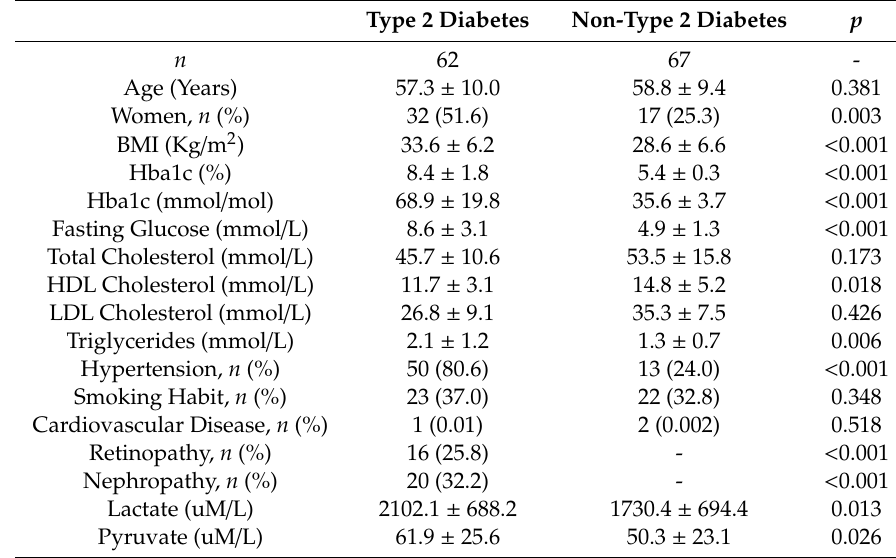
Table 1. Clinical and anthropometric data of the study population according to the presence of type 2